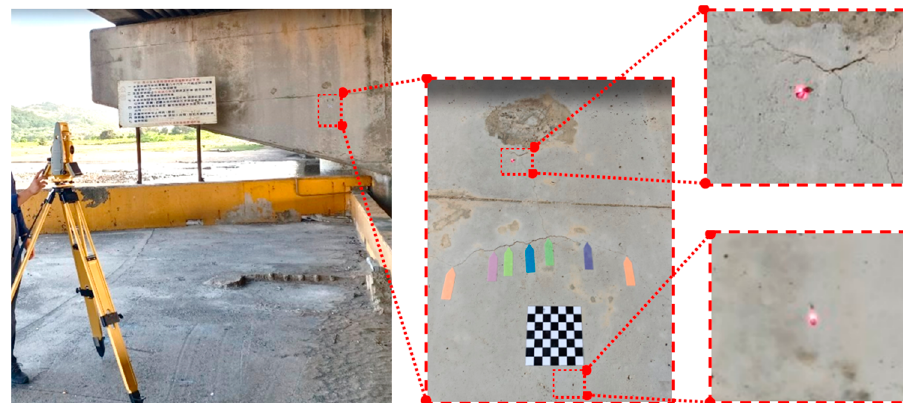
Figure 4. Affix the planar marker.